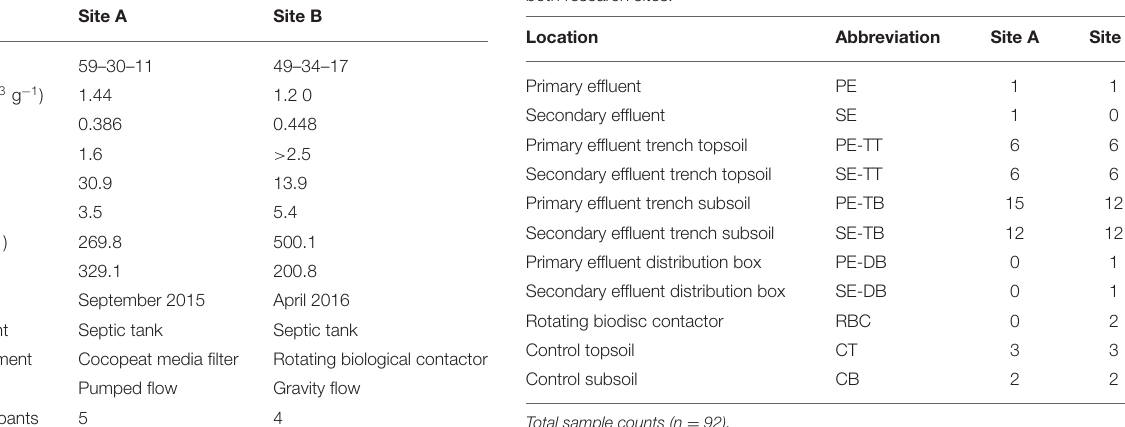
TABLE 1 | Soil and hydrological parameters of both sites (Knappe et al., 2020). TABLE 2 | The sample counts for each on-site wastewater treatment systems for both research